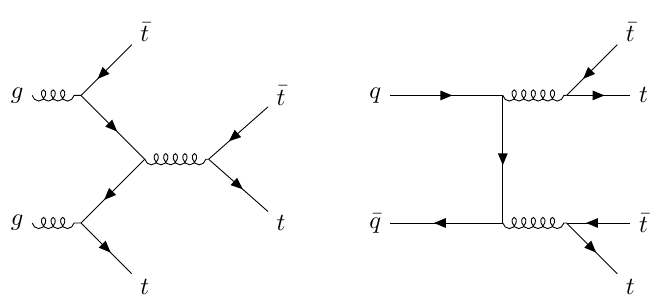
) for the gg -initiated s